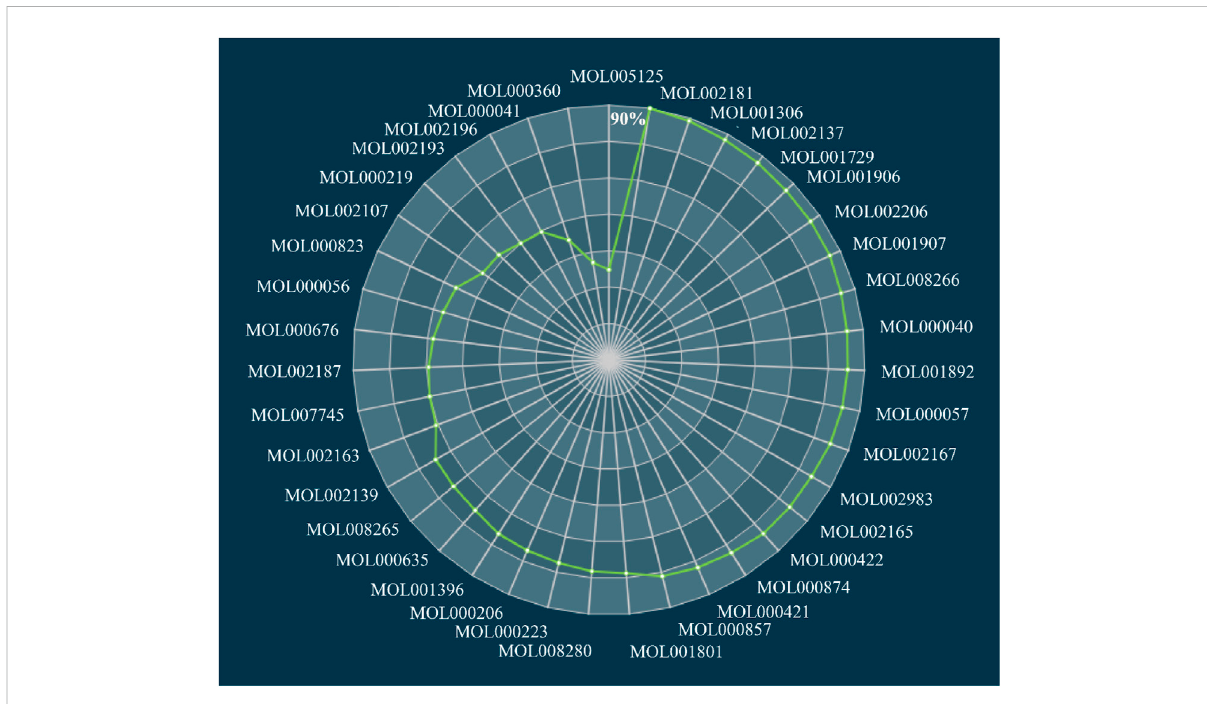
FIGURE 6 Accumulative FCG score of active components in DSS. FCG, functional components group; DSS,